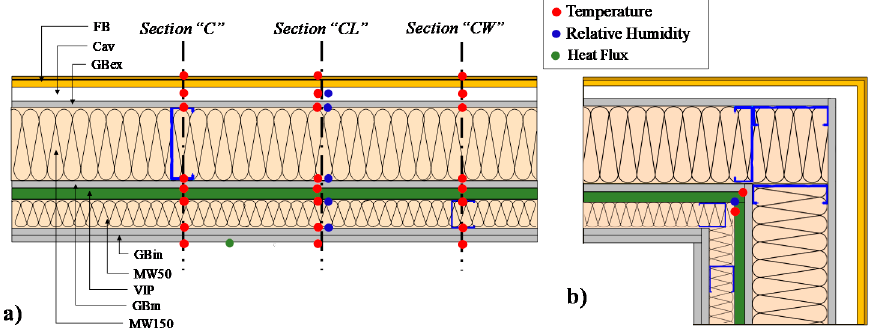
Figure 4. Indicative locations of the sensors for ( a ) central part of the walls and ( b ) the junctions of the building envelope.